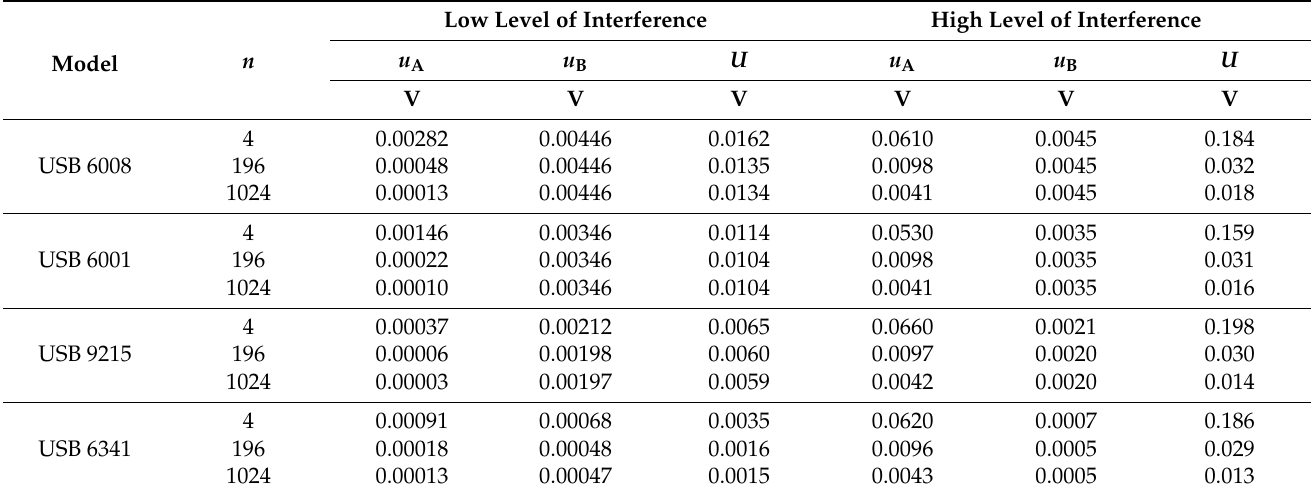
Table 3. Comparison of uncertainties for tested measurement modules for n = 4, 196,